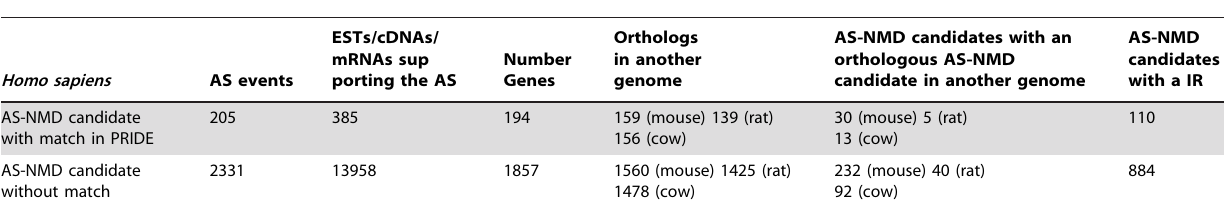
Table 7. Comparison between human AS-NMD candidates with and without matches in PRIDE database.